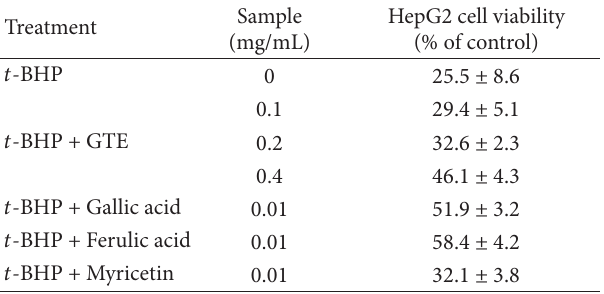
T 6: e antimutagenicity of the aqueous extract of guava twigs (GTE) toward S. typhimurium TA98 and